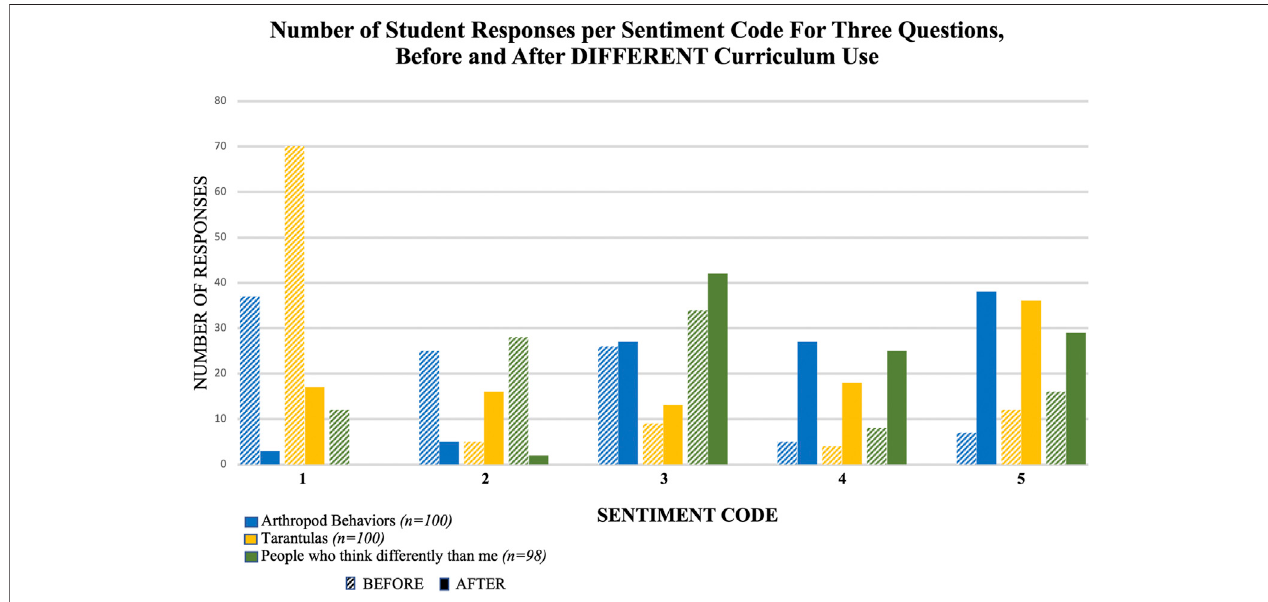
FIGURE 1 | Frequency of student responses for each sentiment category (1 – 5) for three statements before and after the DIFFERENT curriculum intervention. Response code categories are as follows: Negative, 1; Negative-Neutral, 2; Neutral, 3; Positive-Neutral, 4; Positive, 5.